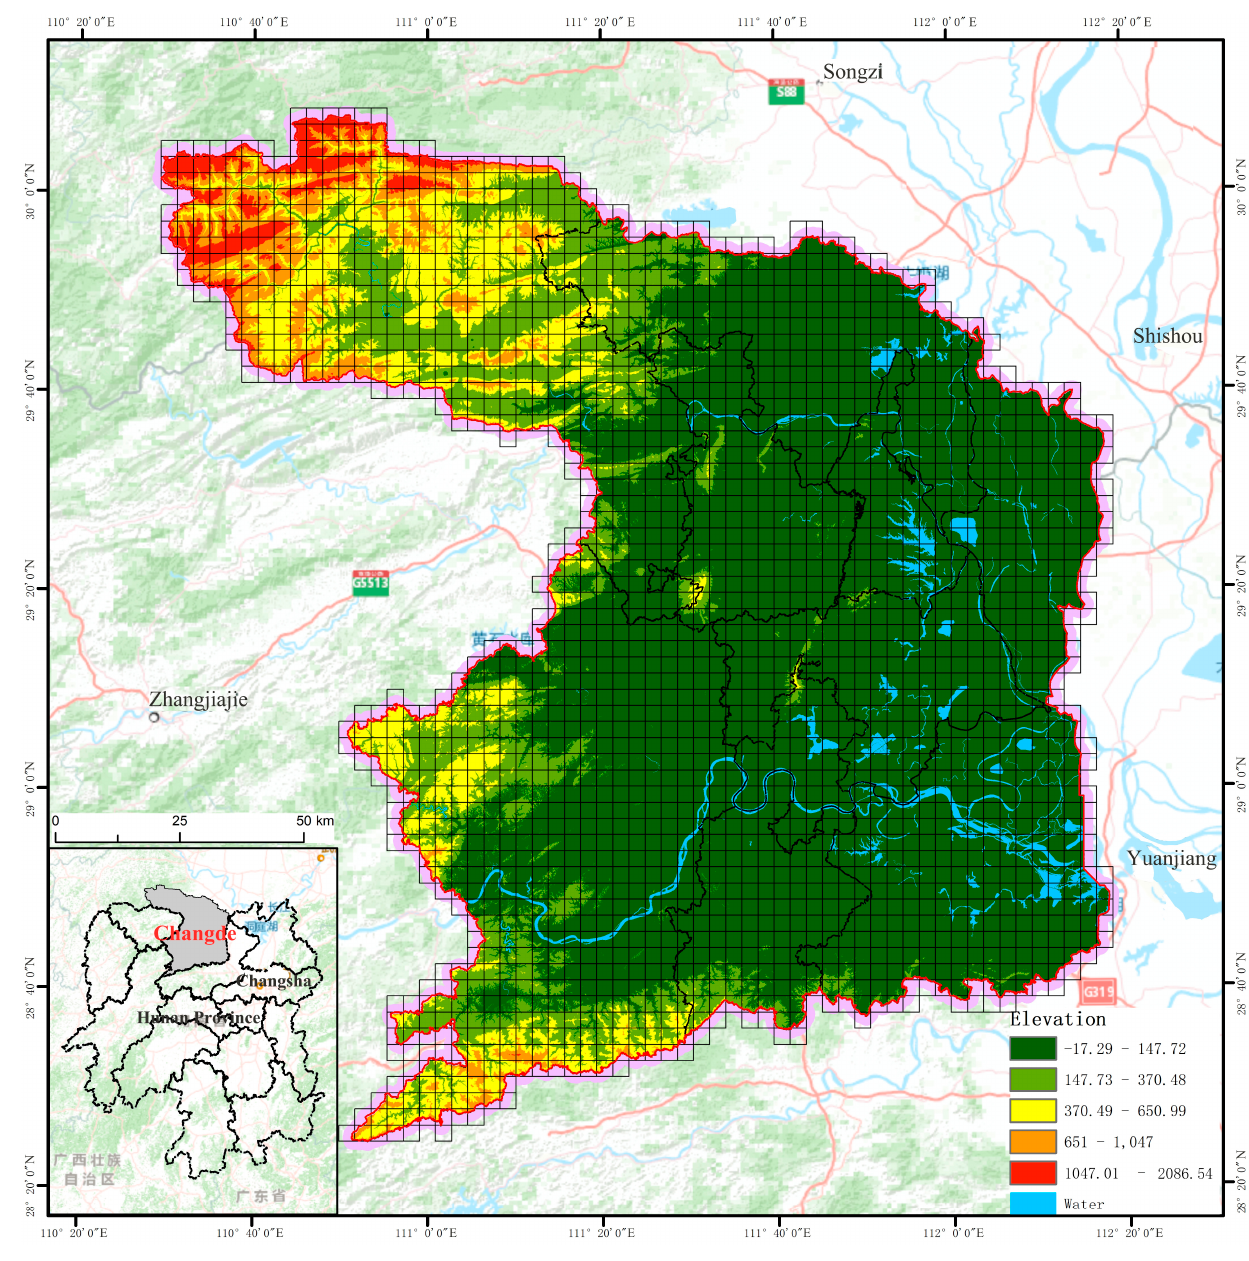
Figure 1. The Spatial Location of the Study Area. Table 2. Data Information and